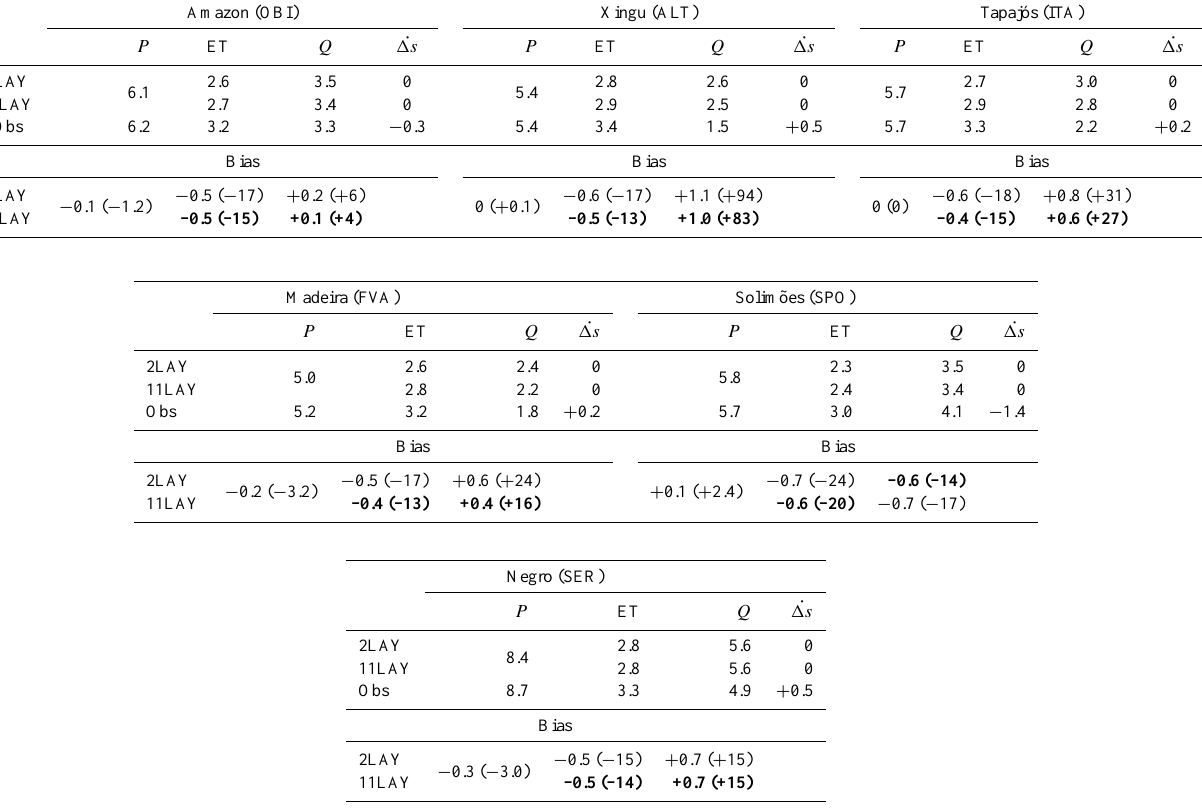
Table 4. Mean annual values (mmd − 1 ), and bias against the observations (in mmd − 1 and % in brackets), of the water budget components simulated by the 2LAY and 11LAY, for each sub-basin, averaged over the period 1980–2008. The bold values indicate the smallest bias between the 2LAY and 11LAY for a given